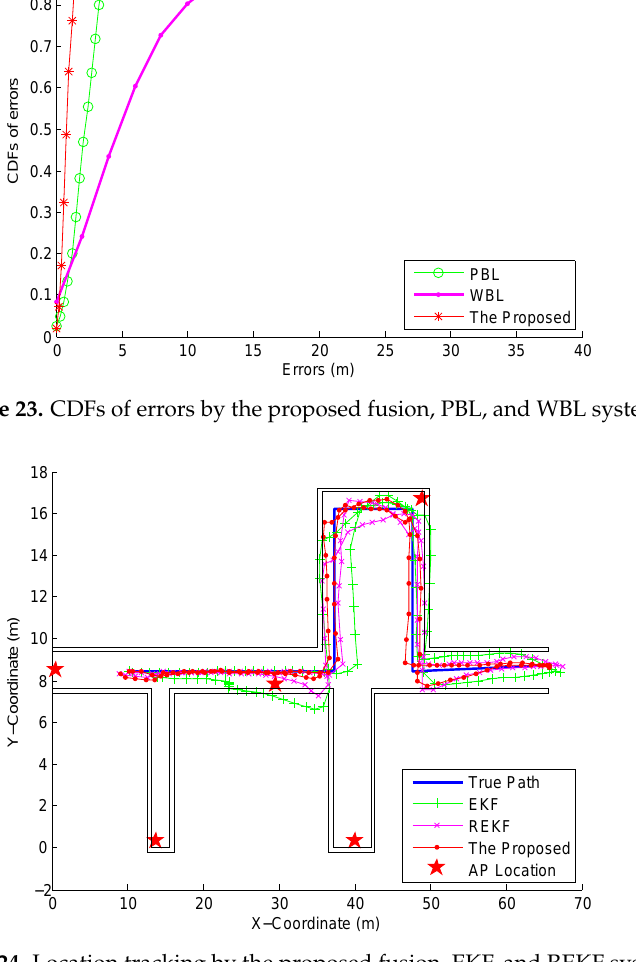
Figure 24. Location tracking by the proposed fusion, EKF, and REKF